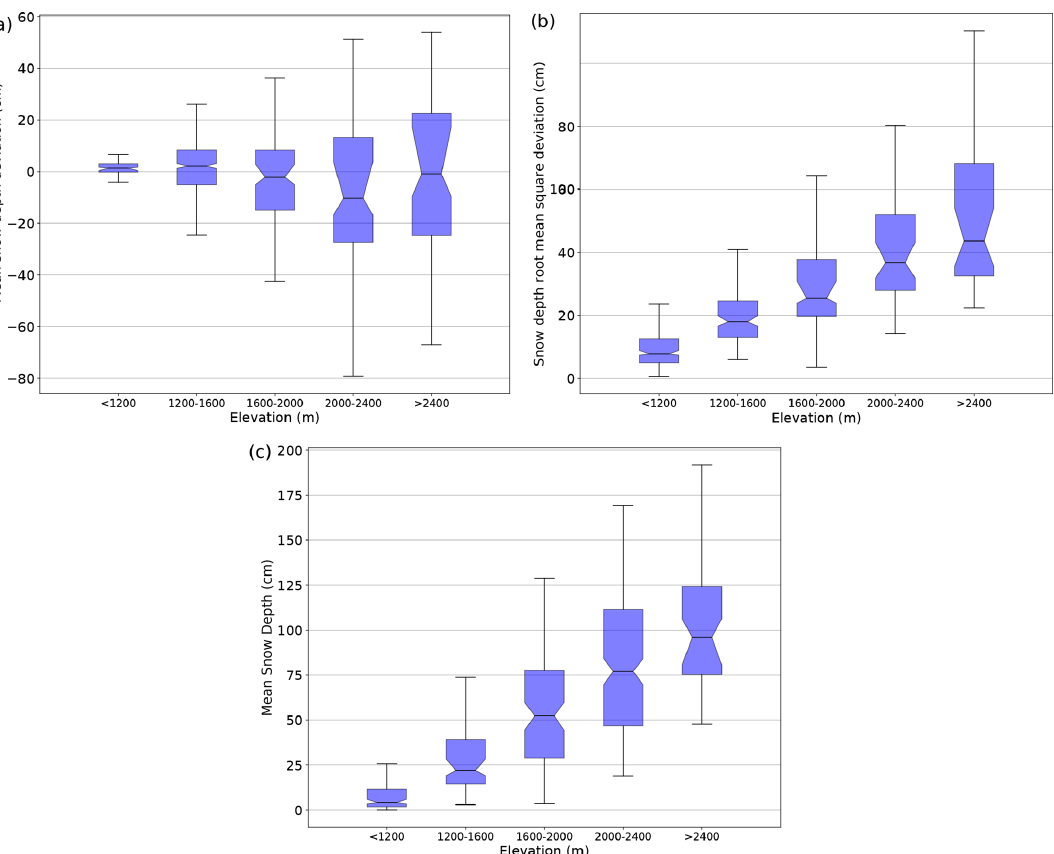
Figure 13. Mean deviation, root mean square deviation between the simulated and observed snow depths values, and mean simulated snow depth on the 665 validation sites grouped by elevation